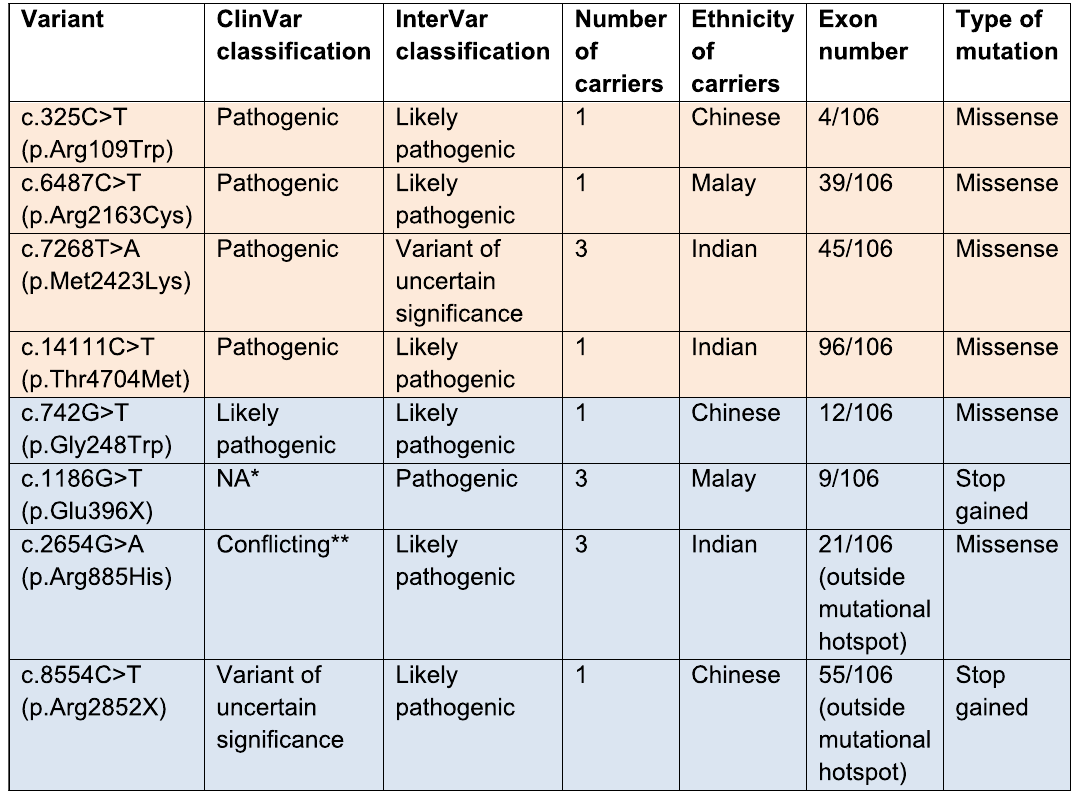
Table 1. Pathogenic and likely pathogenic RYR1 variants in the Singapore population. Both ClinVar and InterVar classifications are included in this table. (Orange: defined as pathogenic in this study; Blue: defined as likely pathogenic in this study). *Not found in ClinVar. **Conflicting refers to when different submitters assign different clinical significance to a variant. This includes variants which have the following combination of classifications from different submitters: 1. (Pathogenic or Likely pathogenic or Benign or Likely benign) AND Uncertain significance. 2. (Pathogenic or Likely pathogenic) AND (Benign or Likely